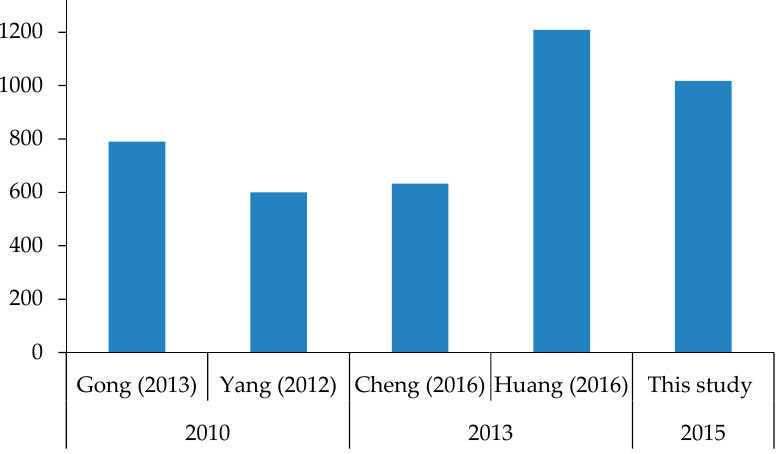
Figure 2. Comparison of industrial VOC emissions in this study with other published results for Hebei province (2010, 2013, and 2015 on the X-axis refer to the years when the VOC emission inventory was established).